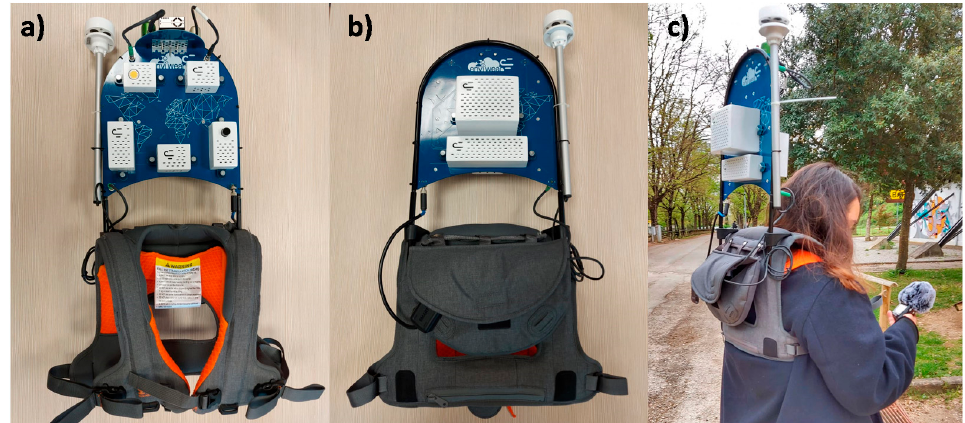
Figure 1. The new wearable system developed for monitoring outdoor environments: ( a ) front view; ( b ) back view; ( c ) system usage during a monitoring campaign.